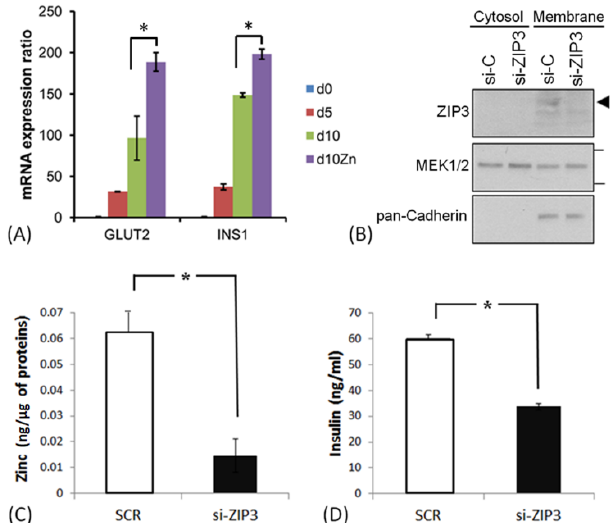
Figure 3. Changes in mRNA levels of GLUT2 and INS1 as SHED cells mature into insulin-producing and -secreting SHED β -cells. Panel ( A ) shows mRNA expression of GLUT2 and INS1 at d10 in response to supplementation with 50 μ M zinc (n = 3, * p < 0.01). ( B ) Western blot analysis of ZIP3 protein in membrane and cytosol of SHED β -cells. Arrowhead approximates the position of molecular weight (M.W.) of 34. Note the siRNA knocked down ZIP3 band expression on the right-most column for siZIP3 extracted from the membrane. MEK1 / 2 are ubiquitous kinase enzymes. Note that pan-Cadherin expresses in the membrane only. ( C ) E ff ects of ZIP3 knockdown on zinc levels compared with cells treated with scrambled (SCR) siRNA. ( D ) E ff ects of ZIP3 knockdown on insulin secretion compared with cells treated with scrambled (SCR) siRNA. * p <